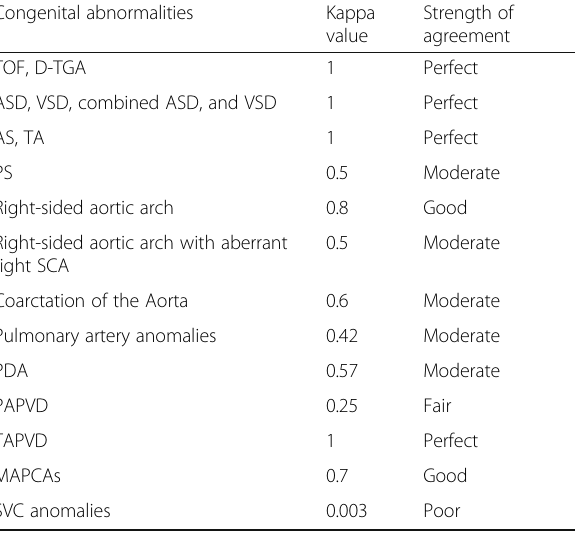
Table 3 The agreement between MDCTA and TTE in different intra- and extra-cardiac anomalies detected in the